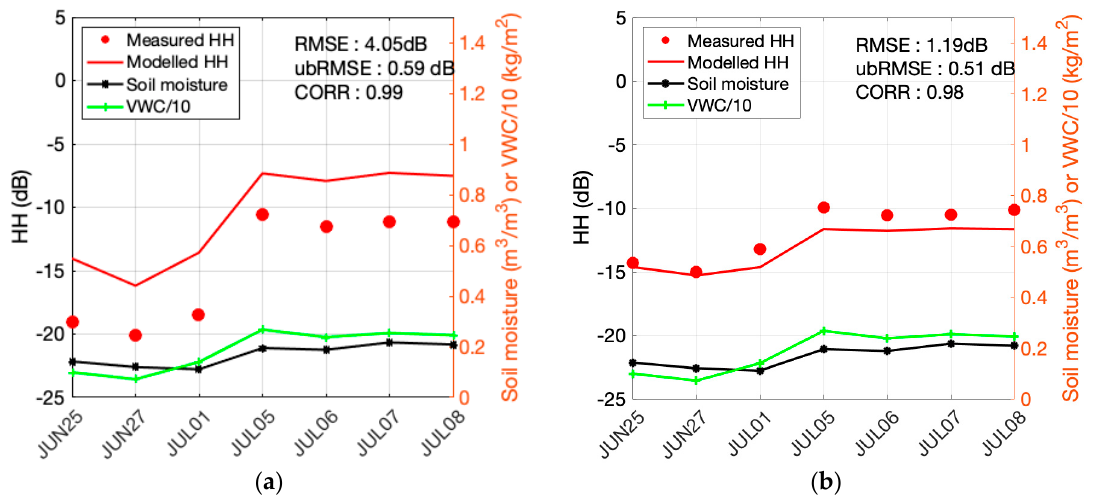
Figure 5. Forward model comparison of corn field at site 6 with rms height equal to 0.92cm ( a ) L-HH ( b ) S-HH. Table 4. Forward model comparison of backscattering coefficients for soybean. Within parenthesis are ubRMSE in dB, RMSE in dB, and correlation.